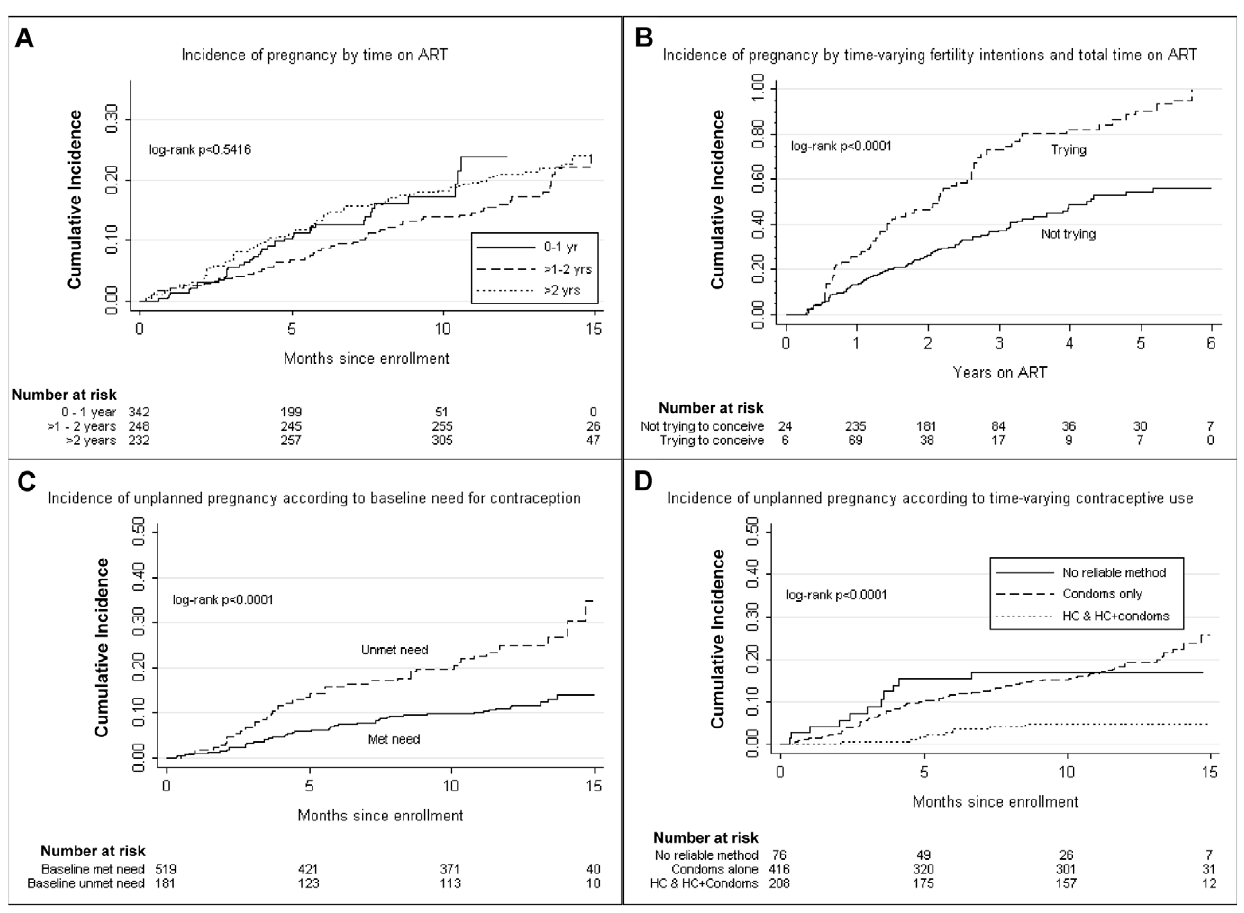
Figure 2. Kaplan-Meier plots of time-to-first pregnancy amongst women on antiretroviral therapy (ART), South Africa. Time-to-first pregnancy is depicted by: (A) total years-on-ART; (B) time-varying fertility intentions; (C) baseline need for contraception; and (D) time-varying contraceptive use during study follow-up. HC=hormonal contraception .